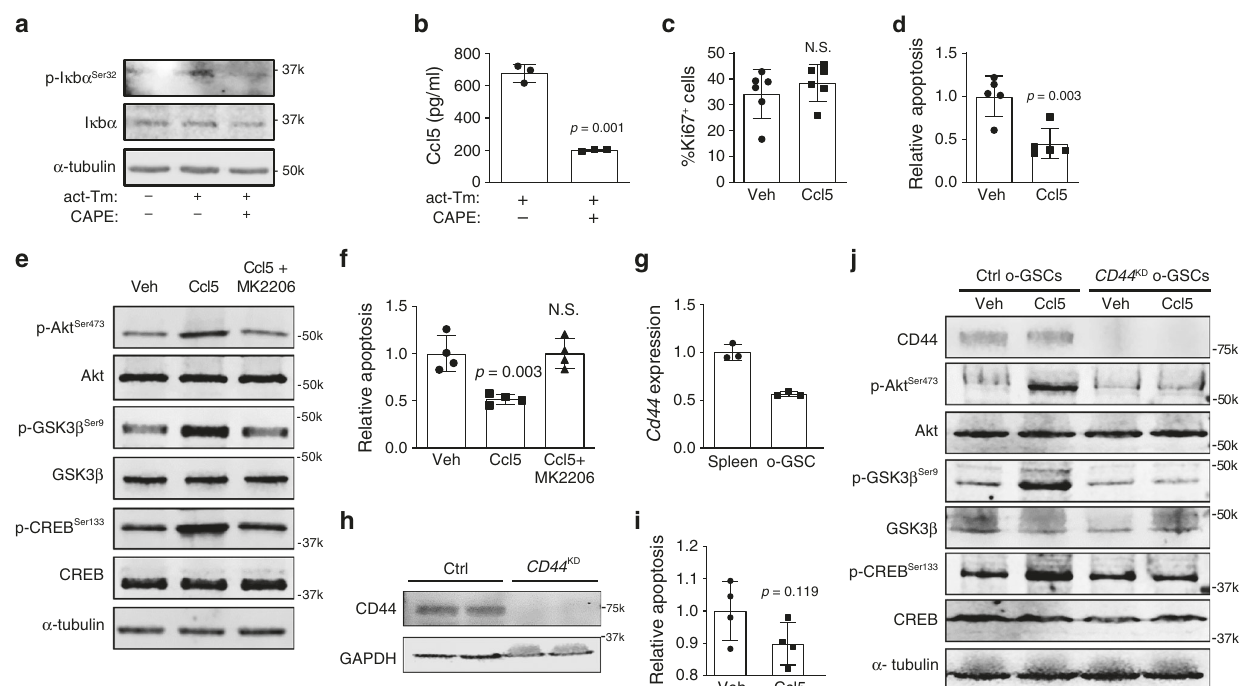
Fig. 7 T cell-mediated microglial Ccl5 production inhibits LGG apoptosis through CD44. a Activated T cell CM (act-Tm) increased I κ b α phosphorylation in microglia, which was reduced following Caffeic acid phenethyl ester (CAPE; 100 µ M) treatment. b CAPE treatment attenuated activated T cell CM (act- Tm)-mediated Ccl5 production in microglia. OPG o-GSCs were stimulated with Ccl5 at 300 pg ml − 1 for 3 days. Whereas no increased optic glioma stem cell (o-GSC) proliferation (%Ki67 + cells) was observed c , o-GSC apoptosis (%TUNEL + cells) was reduced in the Ccl5-treated group compared to vehicle (Veh, 0.1% BSA) treated controls d . e Immunoblotting reveals activation of the Akt-GSK3 β -CREB anti-apoptosis pathway following Ccl5 treatment, which was inhibited by AKT inhibitor (20 μ M MK2206) treatment. f 20 μ M MK2206 treatment inhibited the anti-apoptosis effect of Ccl5 on o-GSCs (%TUNEL + cells). g Cd44 expression in o-GSCs was detected by qRT-PCR using splenocytes as a positive control. Cd44 expression differences were not statistically analyzed. h CD44 knockdown ( CD44 KD ) in o-GSCs reduces CD44 expression relative to the control shRNA-treated (Ctrl) cells. i Apoptosis (%TUNEL + cells) of CD44 KD o-GSCs was not inhibited by Ccl5 treatment. j Immunoblotting reveals that Ccl5 activation of the Akt/GSK3 β /CREB